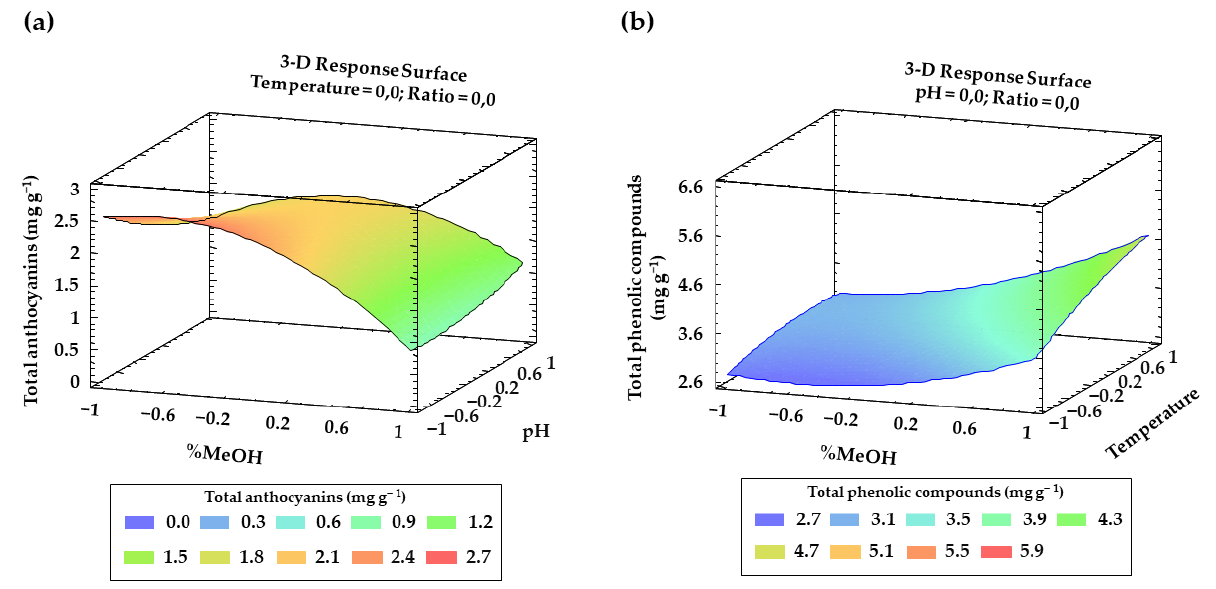
Figure 4. Graphical representation using 3D surfaces of the most significant interactions according to BBD: ( a ) effect of solvent composition and pH on total anthocyanins recoveries (mg g −1 ); ( b ) effect of solvent composition and temperature on the total phenolic compounds recoveries (mg g −1 ).